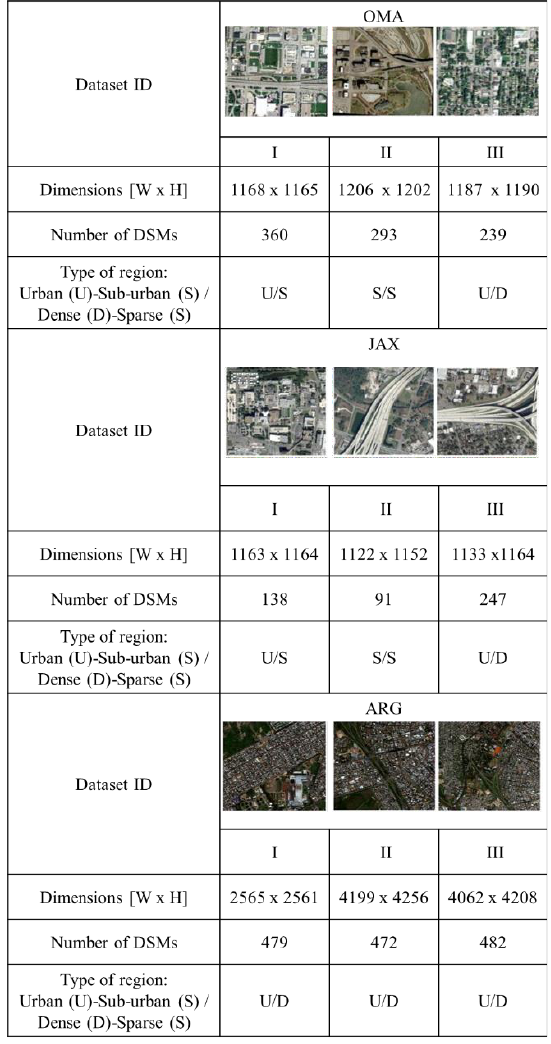
Table 1. The dataset information and testing